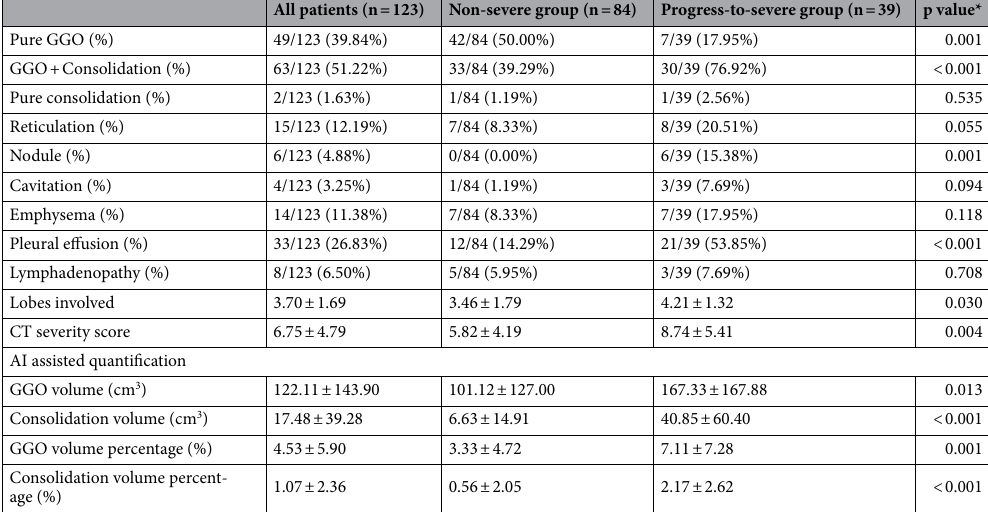
Table 2. Initial chest CT findings between non-severe and progress-to-severe group. AI artificial intelligence, GGO ground glass